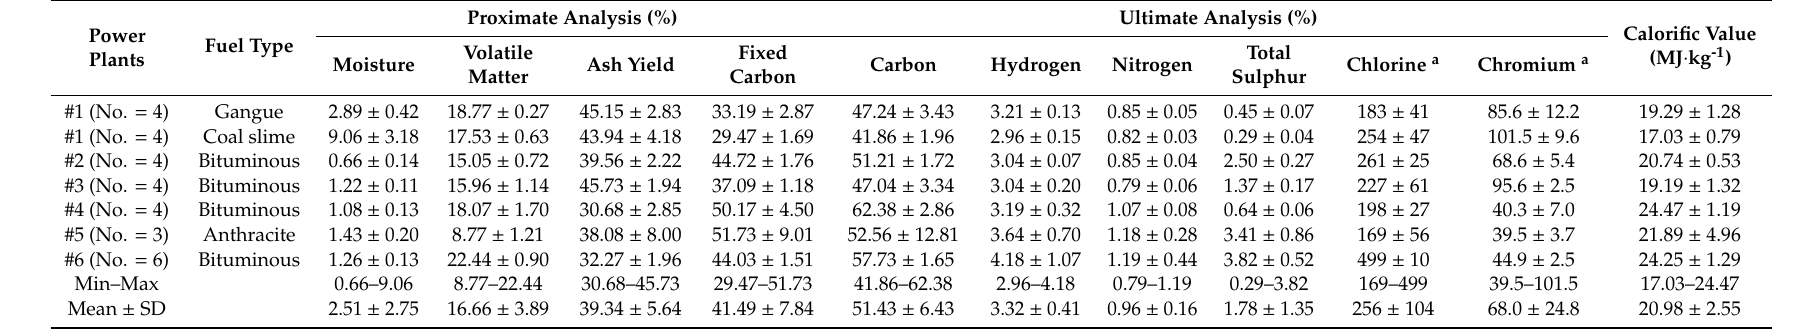
Note: a unit for chlorine and chromium is in mg · kg -1